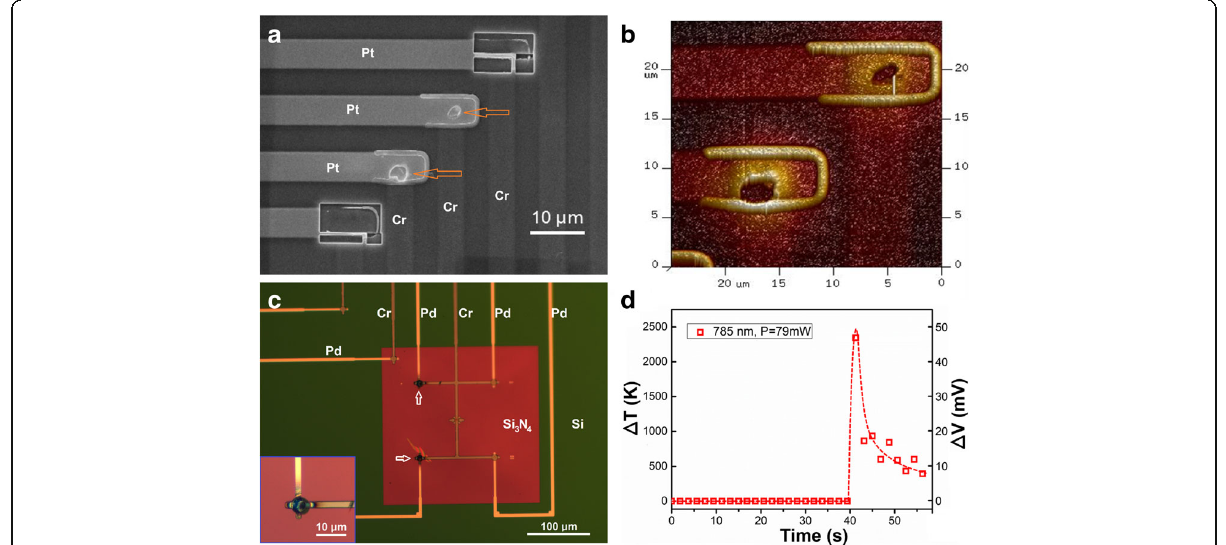
Fig. 2 Local melting effects observed in a SEM. a SEM image of a Pt-Cr TFTC array sample, showing two holes (highlighted with red arrows) were made by e-beam irradiation at the junction regions of two Pt-Cr TFTC sensors. b AFM image of the same two junctions, showing detailed 3D information of the two holes. c Four Pd-Cr TFTC sensors made on a 400-nm-thick, freestanding Si 3 N 4 thin film window. Two TFTCs (highlighted with white arrows) at the left wide of the window were burnt with a focused 785 nm laser. d The corresponding output peak of the Pd-Cr TFTC when it was burnt with the